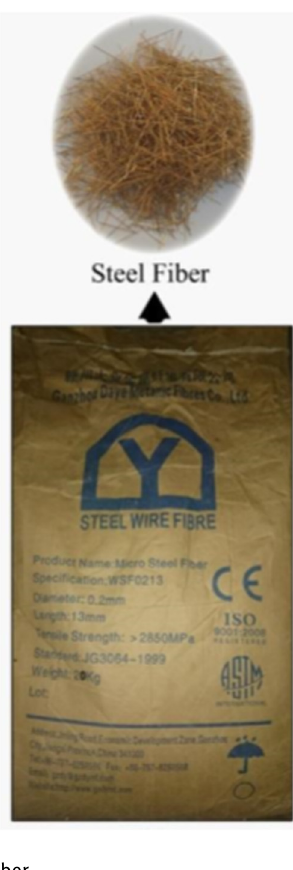
Figure 2: Steel fi ber.